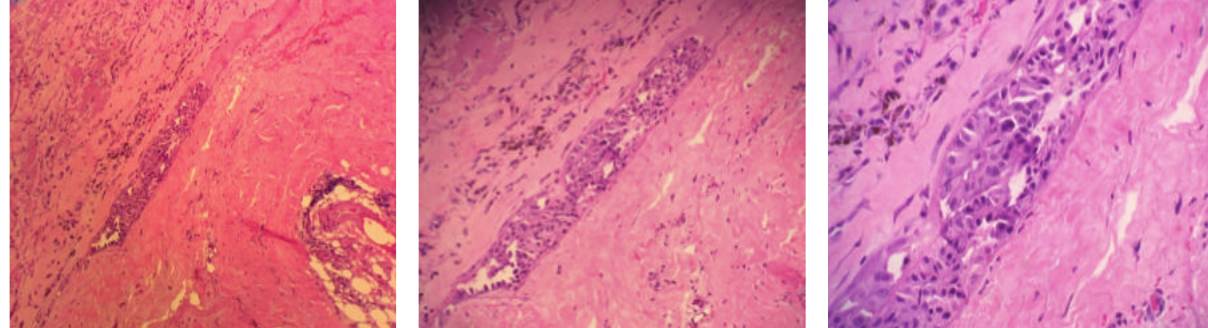
Figure 3: Pericardial biopsy illustrating pathology positive for metastatic urothelial